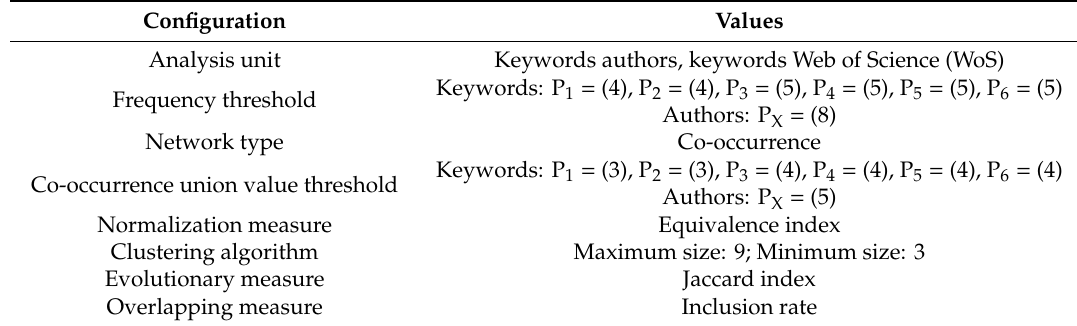
Table 1. Production indicators and inclusion